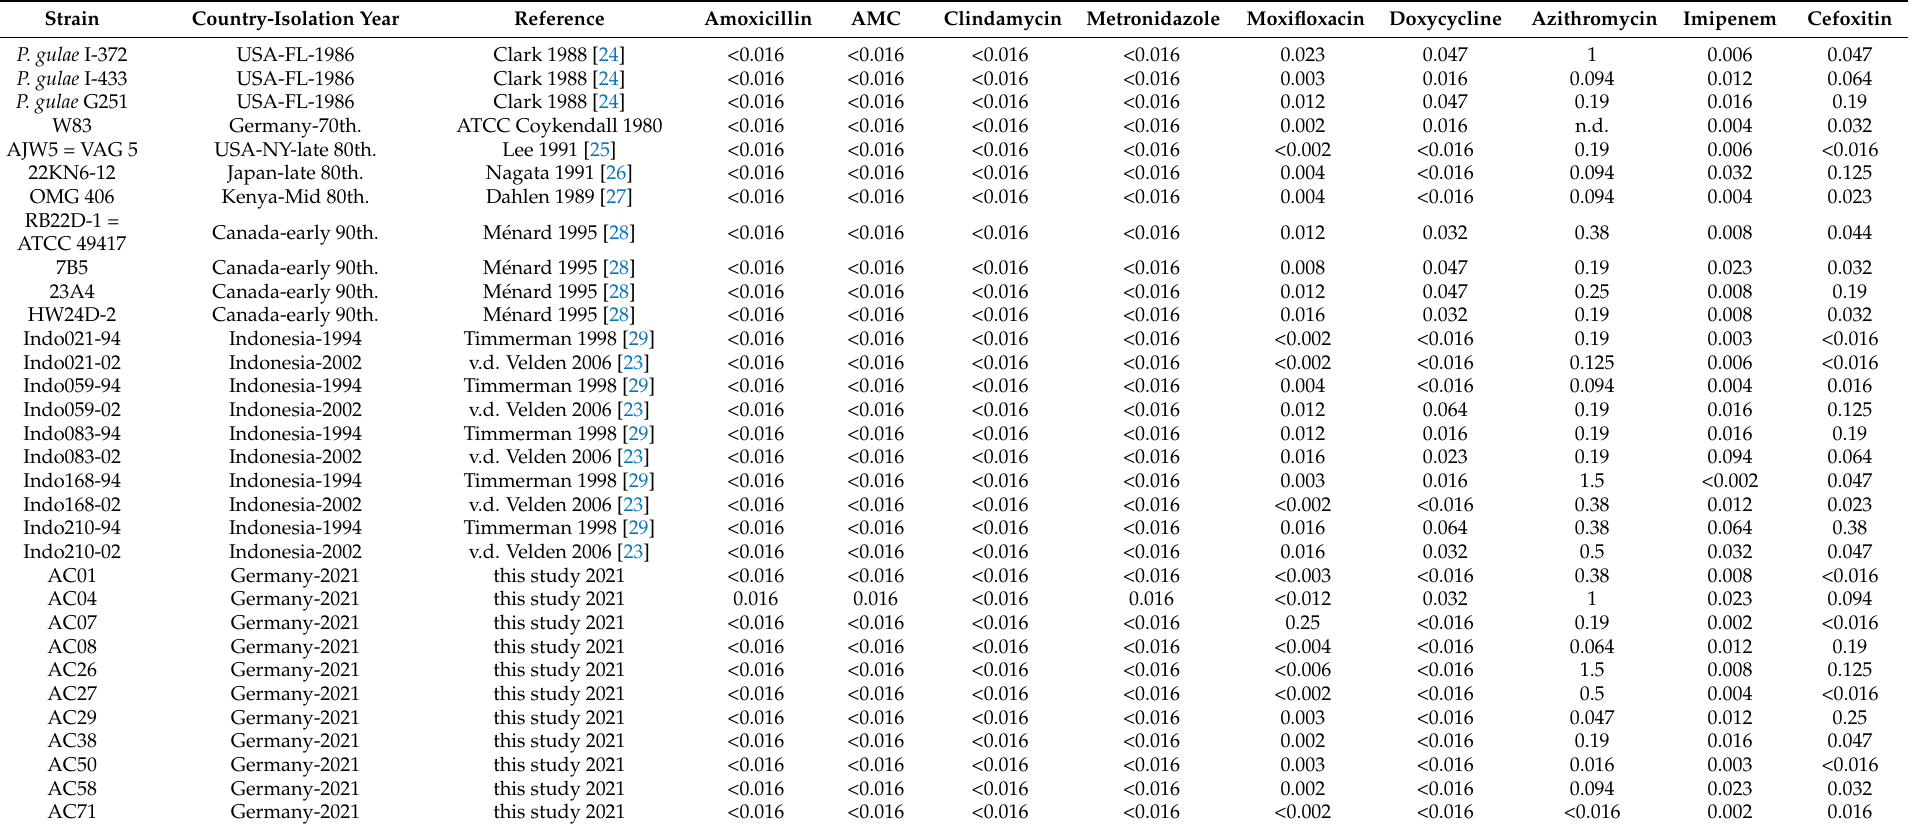
Table 1. In vitro antimicrobial susceptibility of 3 Porphyromonas gulae and 29 P. gingivalis strains (isolated between 1970 and 2021) to nine antibiotics determined by the E test (results in mg/L). Among the tested 31 strains, 20 were retrieved from previous studies while 11 strains were isolated and investigated for the first time during this study. The MIC range, together with MIC50 and MIC90 was calculated and is reported together with breakpoints in Table